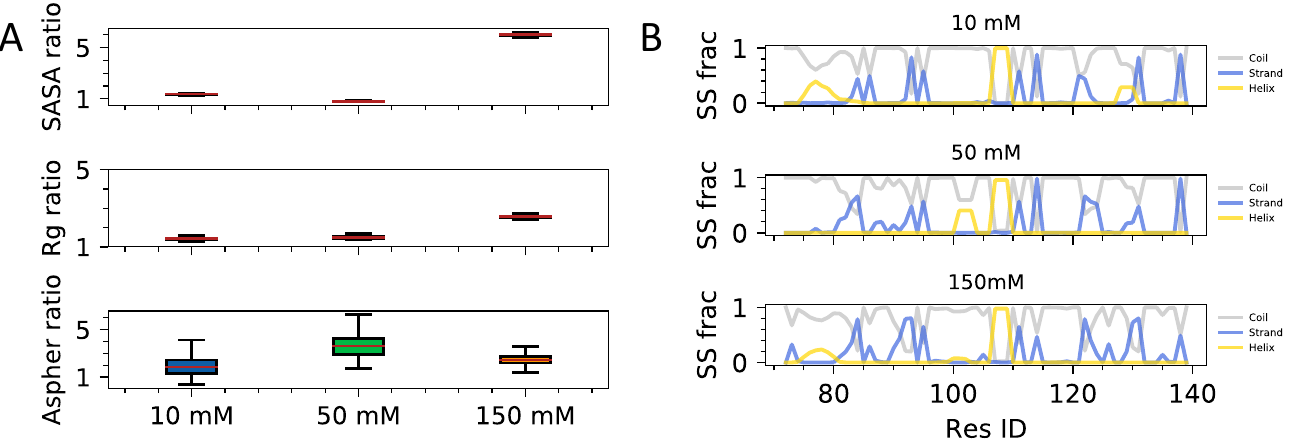
Figure 4. Polymeric properties of hinge region as a function of ionic strength. ( A ) Solvent accessible surface area (SASA), Radius of gyration (Rg), and Asphericity (Aspher) as a function of ionic strength. Error bars show standard deviations from the sampled mean. ( B ) Secondary structure content computed as a function of sequence position. Panels from top to down show results from simulations of single chains, which are part of the fuzzy dimeric complex. Different colors in each panel correspond to coil, strand, and helical